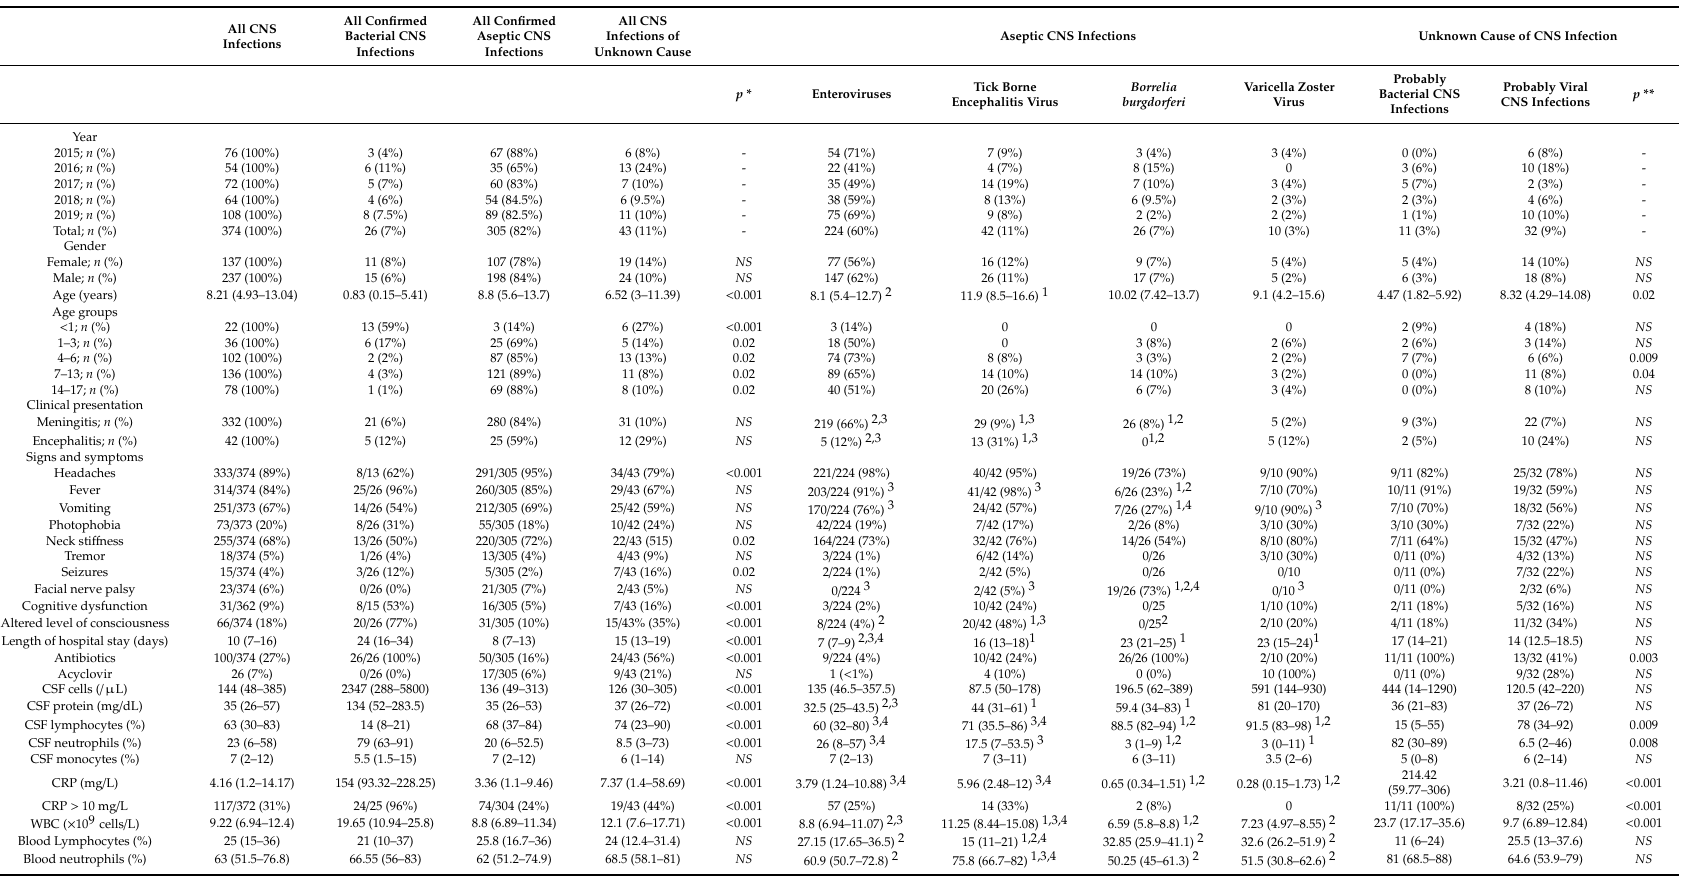
Table 1. Clinical features of study population by cause of the central nervous system (CNS)